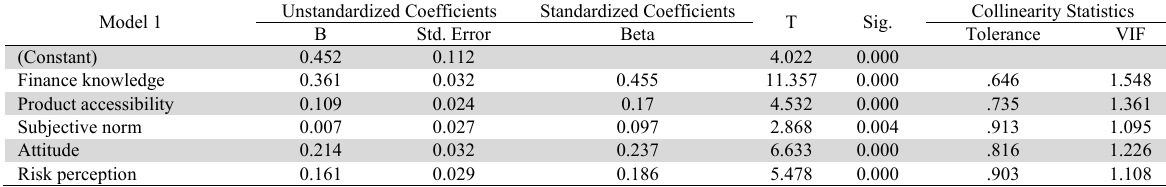
The results of regression analysis